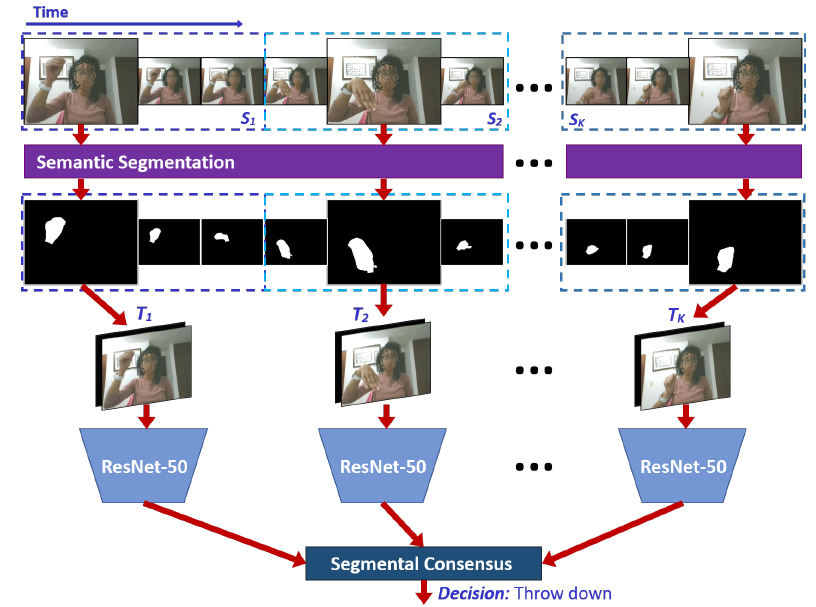
Figure 3. Temporal Segment Networks (TSN) process.